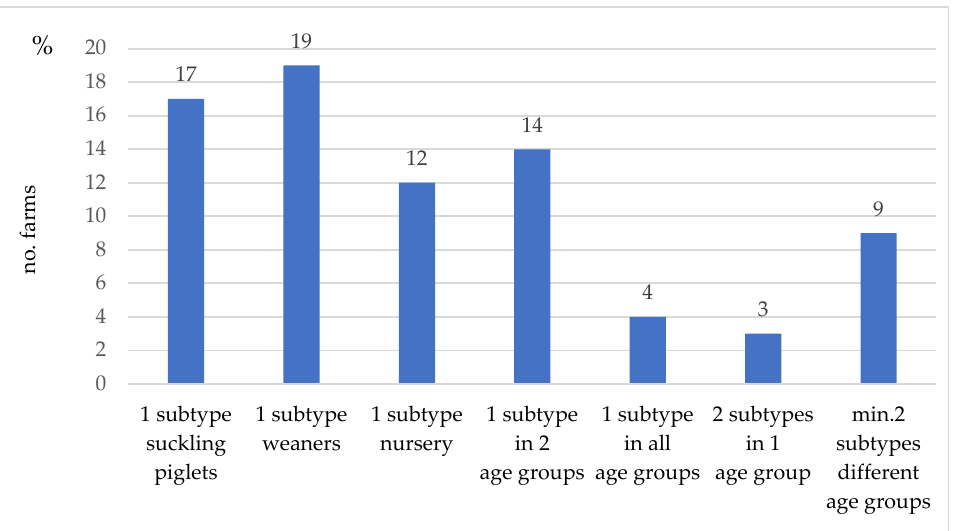
Figure 5. Combinations of IAV subtypes detected/farm/age group in 78 farms, with a minimum of one per multiplex RT-PCR-determined subtype, out of 131 sampled farms.